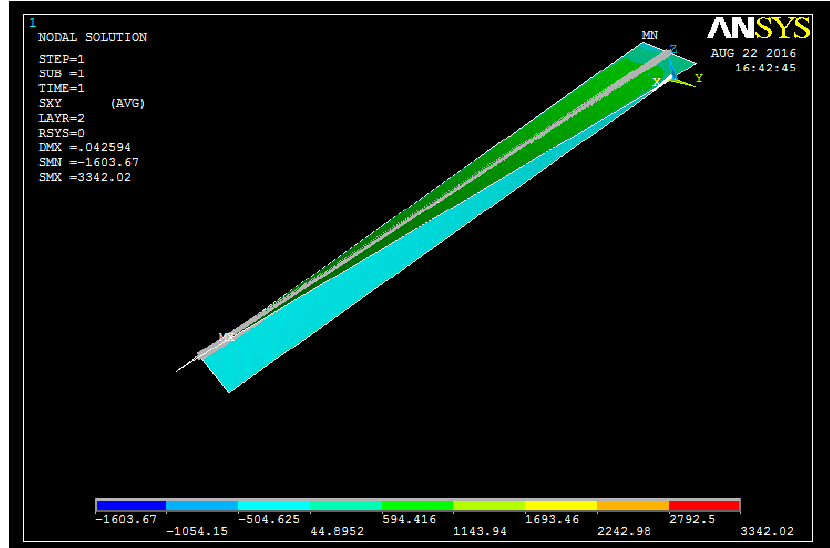
Figure 2: Typical ANSYS output window (shear stress SXY for T-beam on layer 2 under torsion)